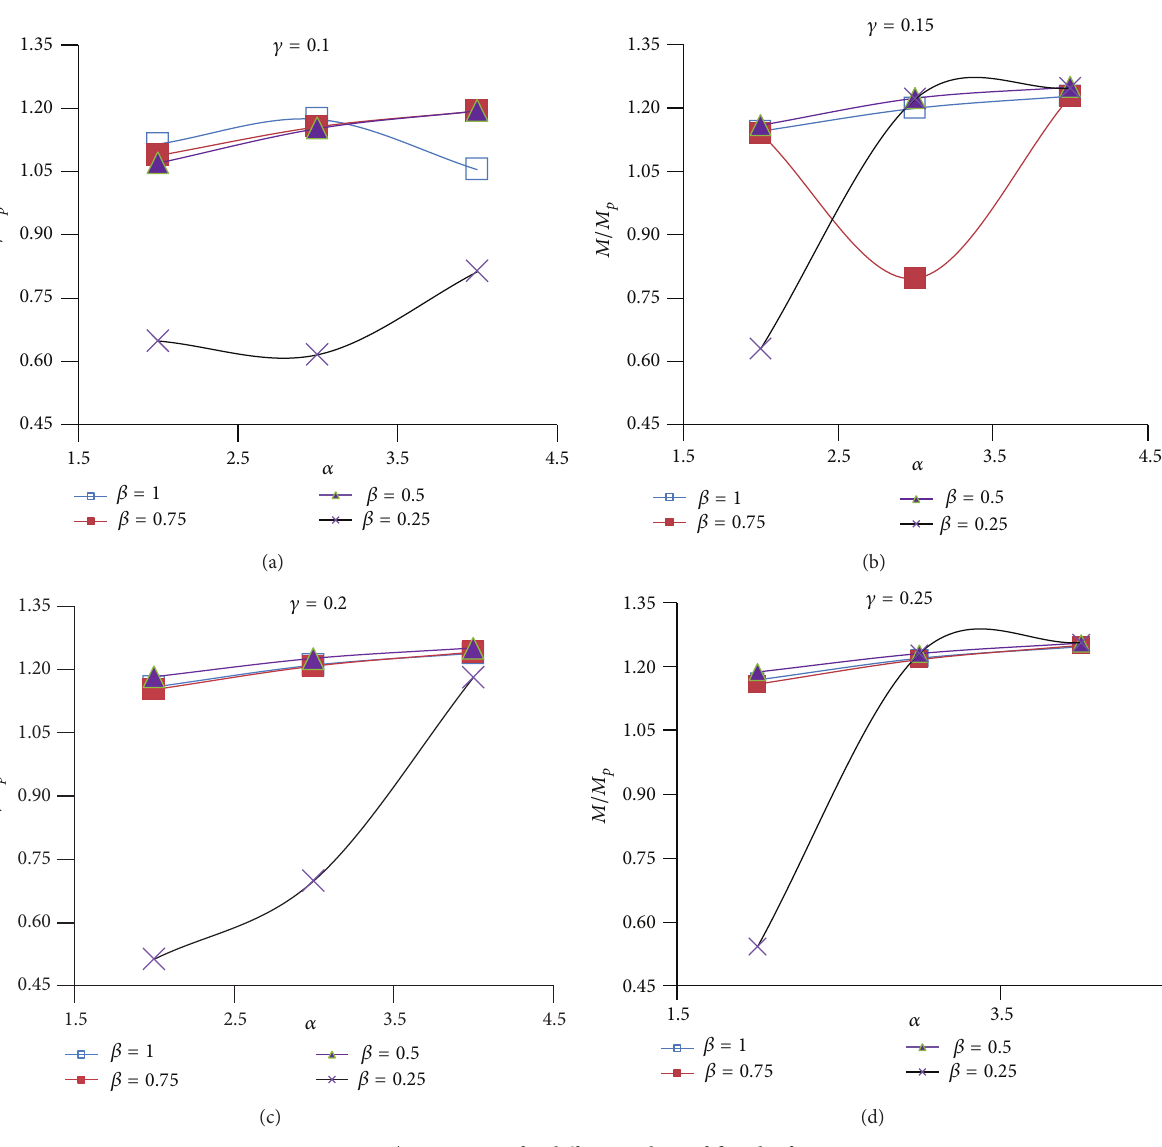
Figure 14: 𝑀/𝑀 𝑃 versus 𝛼 for different values of 𝛽 and 𝛾 for SAC3. Table 3: Variables 𝐶 1 to 𝐶 7 to predict 𝐶